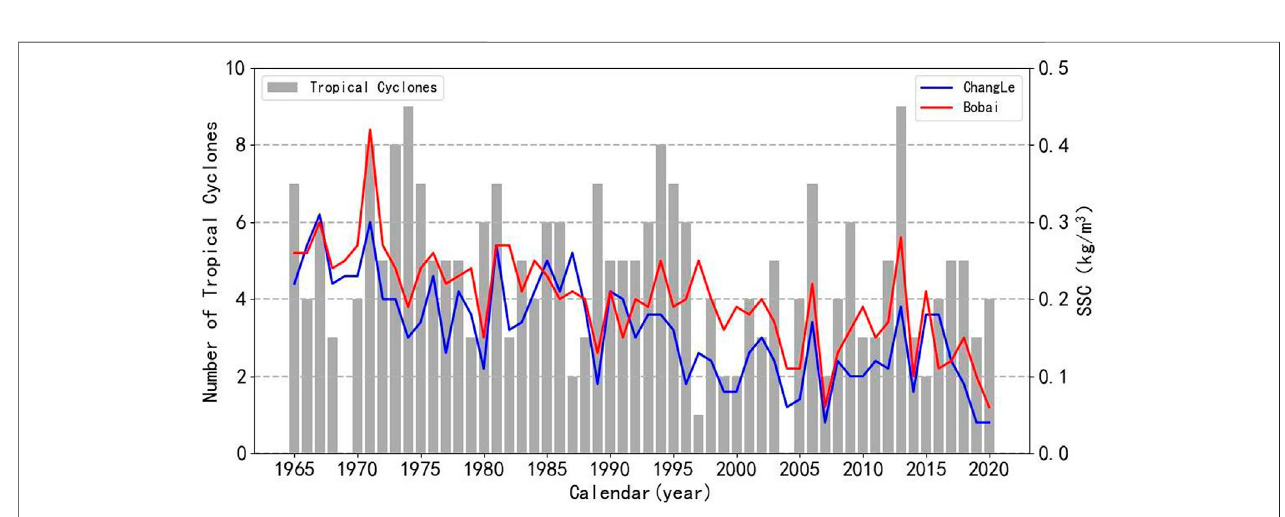
FIGURE 12 | Changes in the number of tropical cyclones and changes in the SSC from 1965 – 2020.